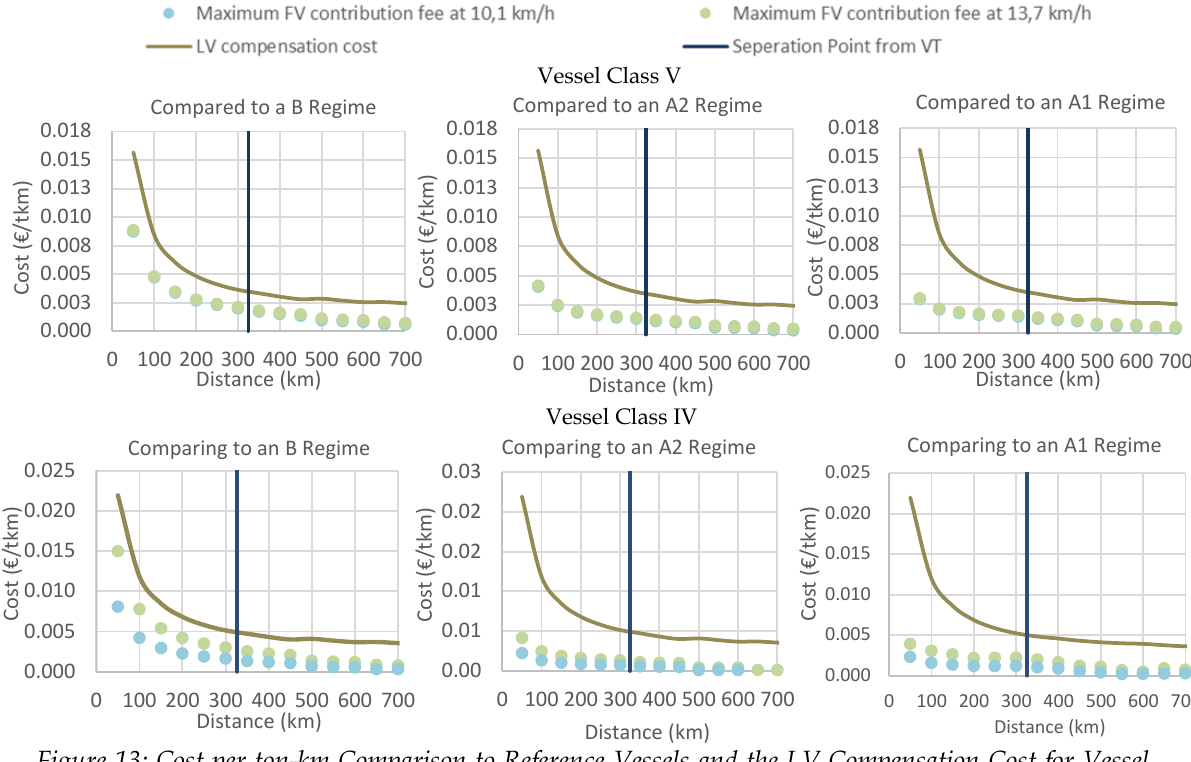
Figure 13: Cost per ton-km Comparison to Reference Vessels and the LV Compensation Cost for Vessel Class V and